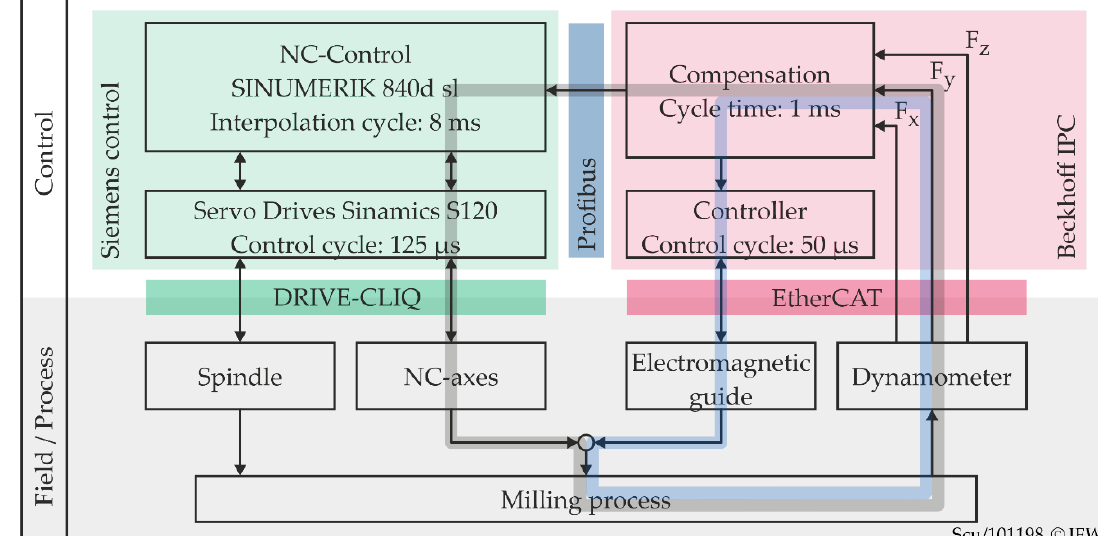
Figure 4. Information flow of the online reactive deflection compensation.